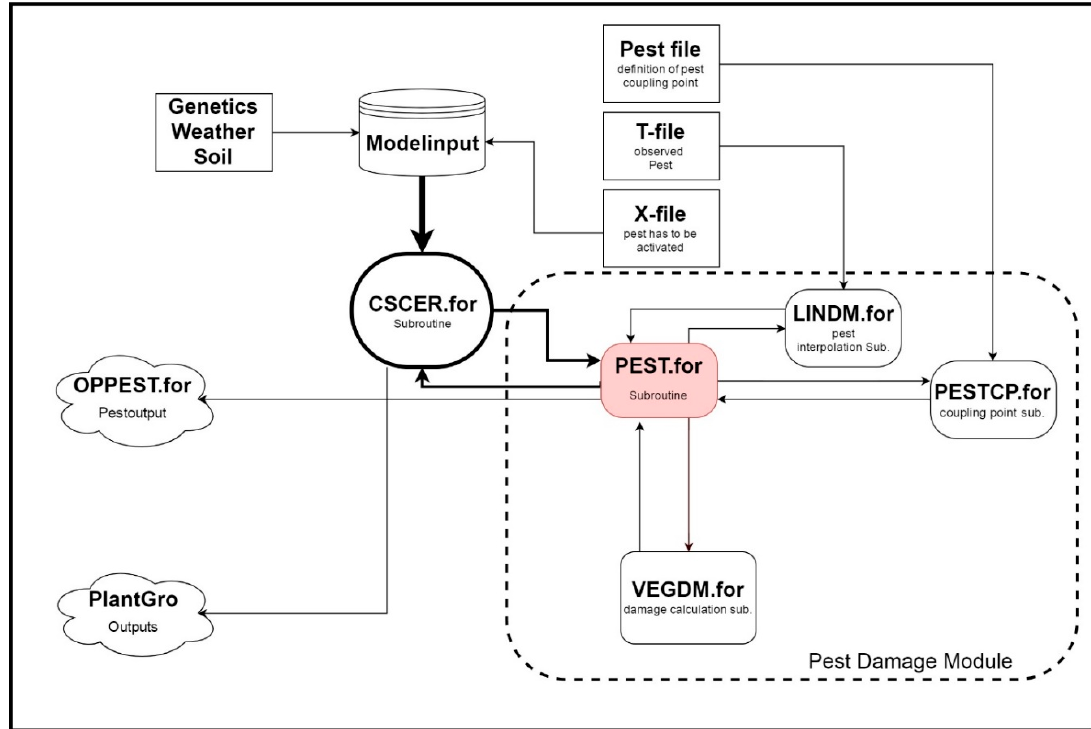
Figure 1. A simplified diagram of the Cropsim-CERES-Wheat (CCW) model with the pest damage module incorporated.